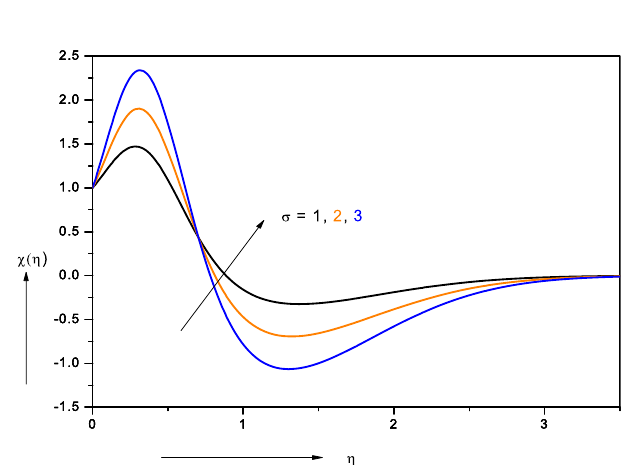
Figure 11. Effect of bioconvection Schmidt number ( Sc ) and bioconvection Péclet number ( Pe ) on motile micro-organism density number.